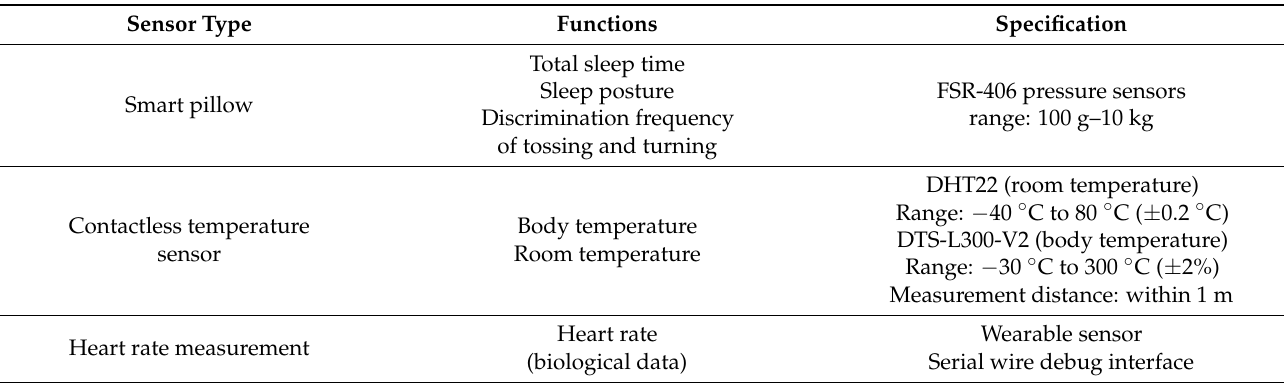
Figure 3. Overall architecture of the sleep pattern monitoring system using nonwearable sensors. Table 1. Functions and specifications of the sensors used in the monitoring system.